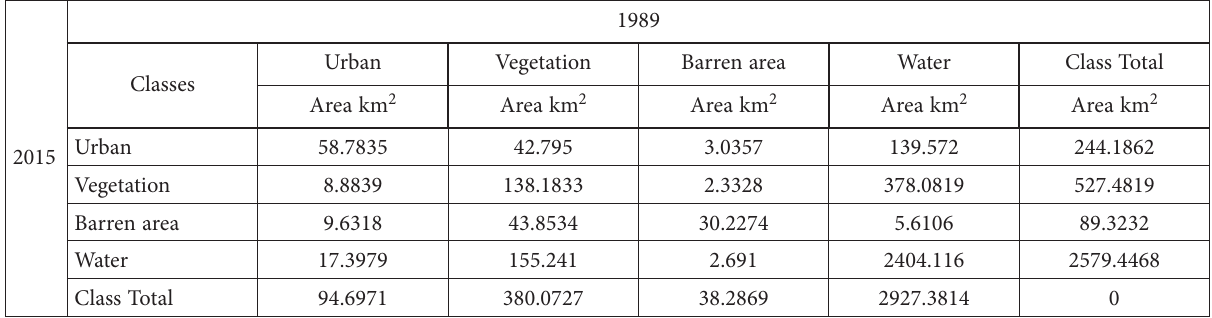
Table 5. The confusion matrix of change area between 1989 and 2015